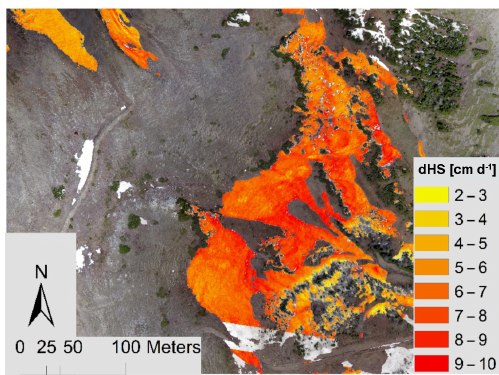
Figure 7. Rate of snow depth change (dHSday − 1 ) between 19 May and 1 June 2015 in the northern portion of the alpine